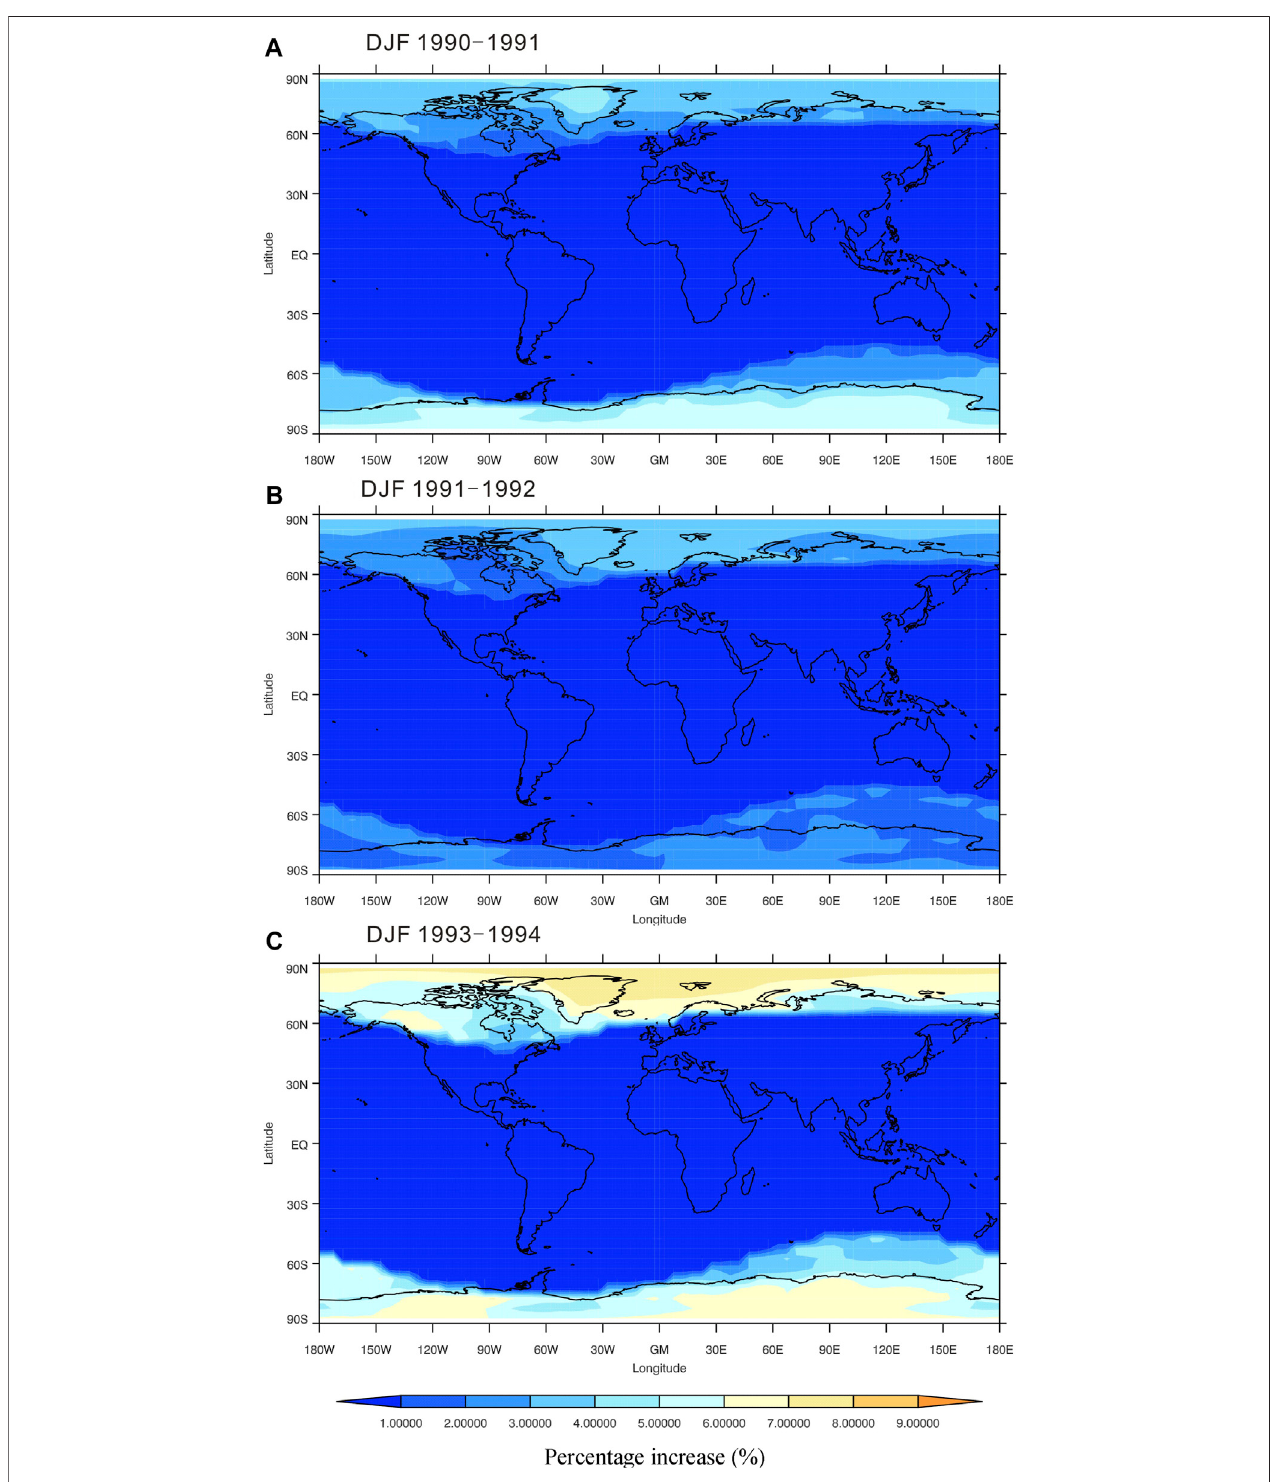
FIGURE10 | The percentage increases((R GCR — R GCR+EEP )/R GCR ) × 100%, of column resistance due todifferentexternalionization sources in DJF (A) 1990 – 1991, (B) 1991 – 1992, and (C) 1993 – 1994.